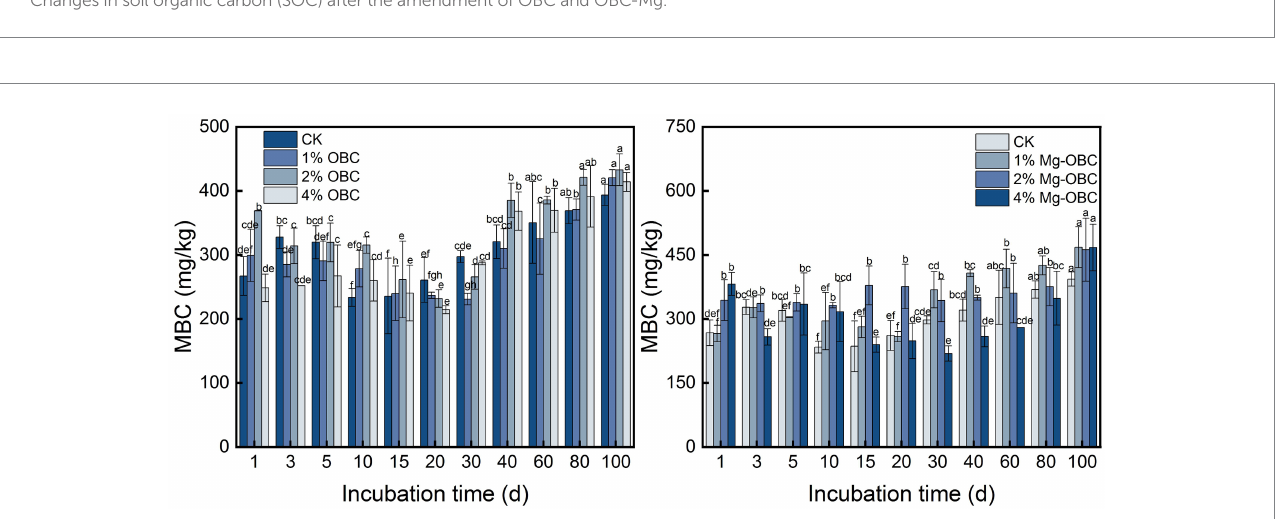
FIGURE 9 Changes in microbial biomass carbon (MBC) after the amendment of OBC and